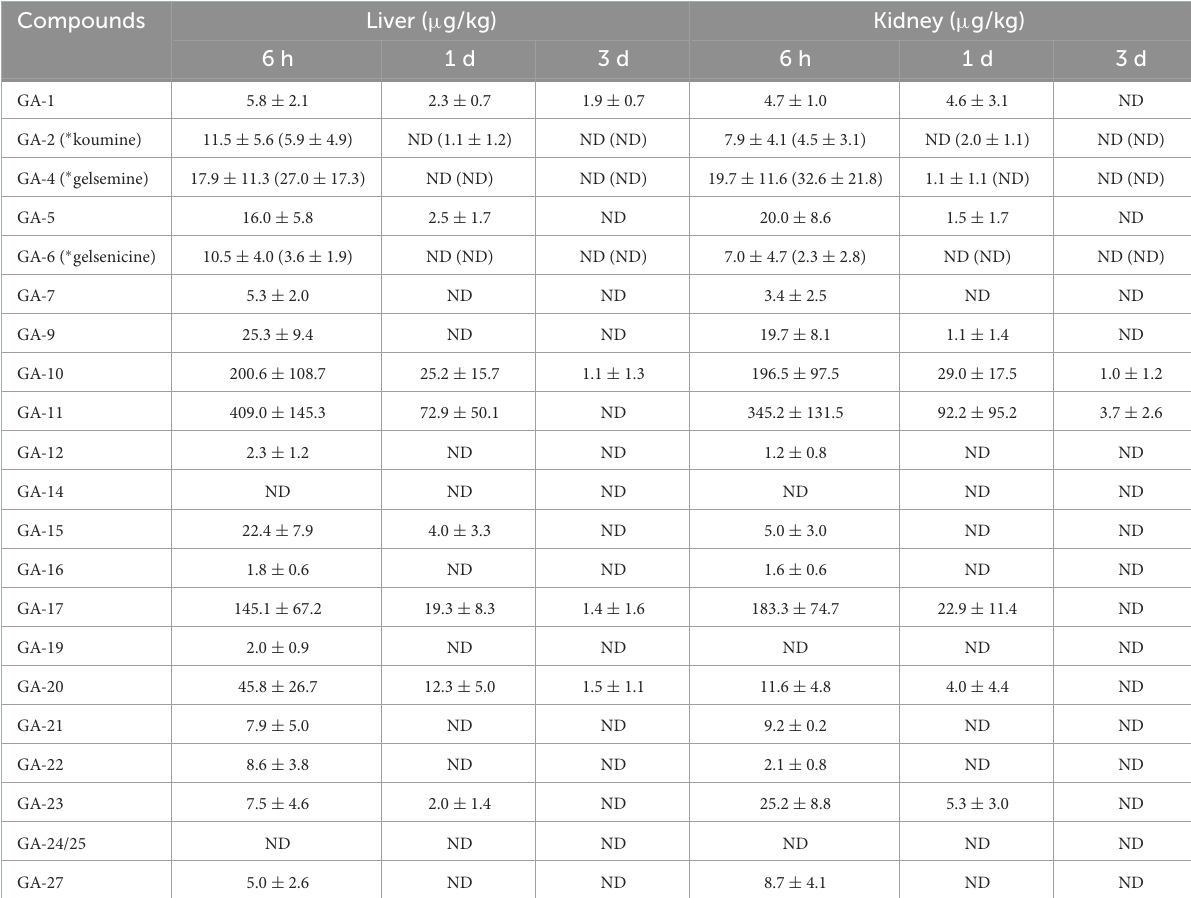
TABLE 3 Concentrations of Gelsemium alkaloids in pig liver and kidney after 45 d of consecutive administered G. elegans powder at a dose of 2% per kilogram feed ( µ g/kg) ( n = 5).